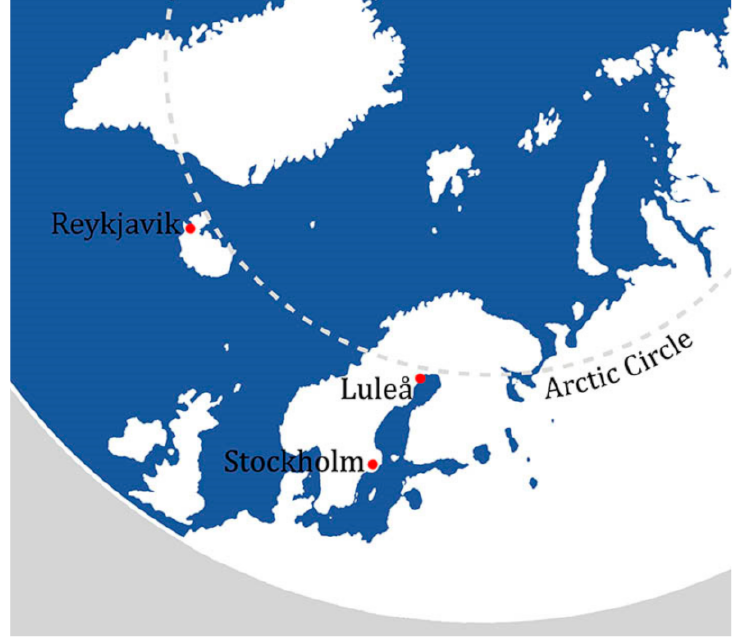
Figure 1. Location map for Luleå,